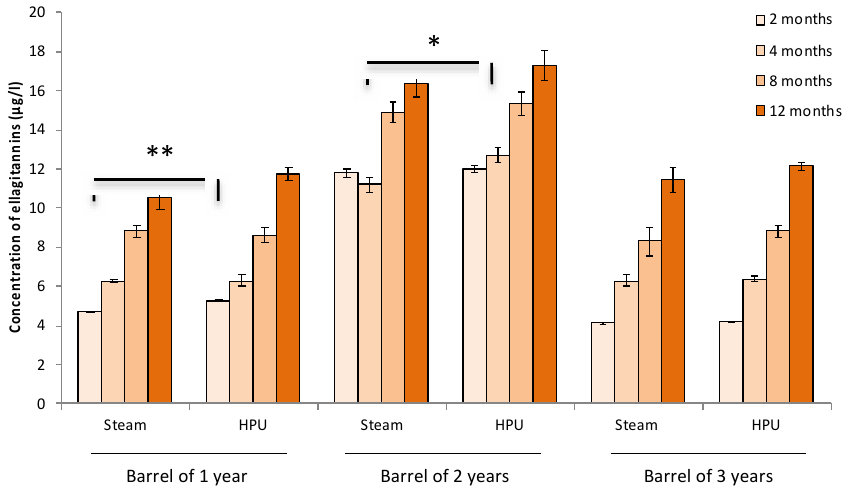
Figure 3. Total ellagitannins concentration of red wine aging for 2, 4, and 8 months in barrels of 1, 2, or 3 years cleaned with HPU hw or steam. (*) significant at p < 0.05; (**) significant at p < 0.01.